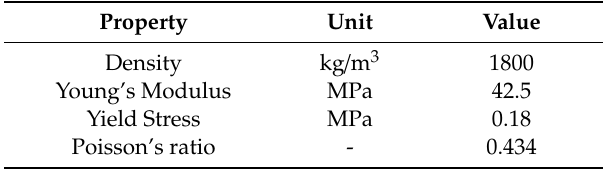
Table 1. Mechanical properties of Plasticine.